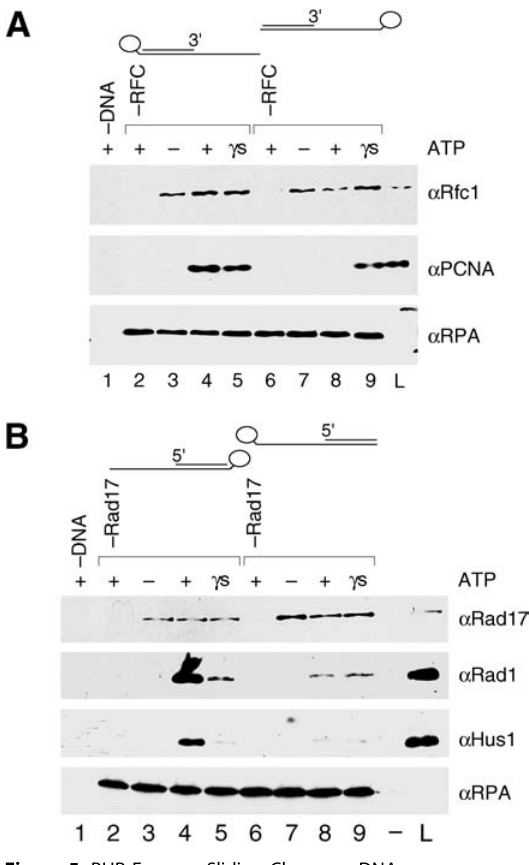
Figure 5. RHR Forms a Sliding Clamp on DNA Loading reactions in the experiments represented in (A) and (B) were performed as described in the Materials and Methods using either recessed 5 9 or recessed 3 9 primer–template DNA–RPA substrates bound to beads, and then recovery of proteins with the beads was analyzed by Wb for the indicated proteins. In each experiment using template strands biotinylated at either the 5 9 or 3 9 end, either both ends of the DNA substrate (reactions represented in lanes 2–5) or only one end of the substrate (reactions represented in lanes 6–9) was blocked by selectively positioning the bead relative to RPA—either at the opposite end of the DNA (distal, therefore both ends blocked) or at the same end of the DNA (proximal, therefore only one end blocked). In (A), lanes represent reactions that contained 0.25 pmol of RFC (except for those in lanes 2 and 6), 2 pmol of PCNA, and either a 3 9 recessed primer/3 9 biotin template DNA (bead distal to RPA;